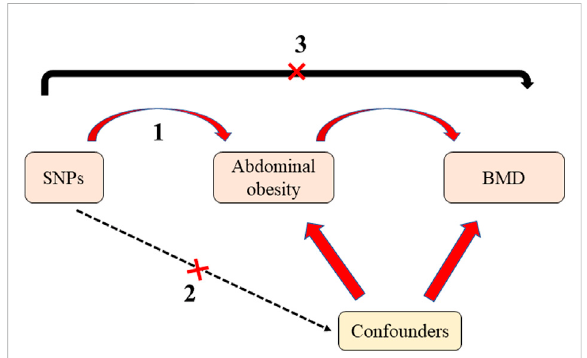
The diagram of Mendelian randomization. There are three assumptions should be met: fi rst, the instrumental variables are closely related to the exposure factor; second, there is no association between the instrumental variables and confounders; third, the instrumental variables should affect the outcome only through exposure factors and not through any other pathway. SNPs: Single nucleotide polymorphisms; BMD: bone mineral